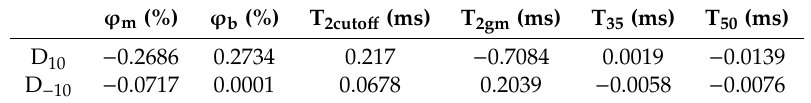
Table 5. The correlation coe ffi cients between multifractal parameters and pore structure parameters. ϕ m (%) ϕ b